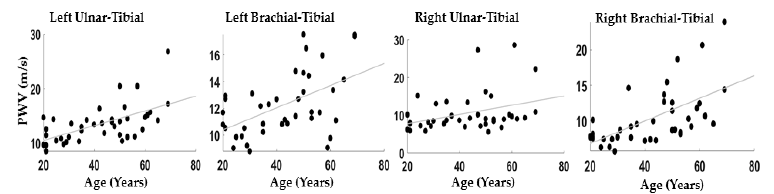
Figure 3. Scatter plot between age ad PWV for all the couples of channels